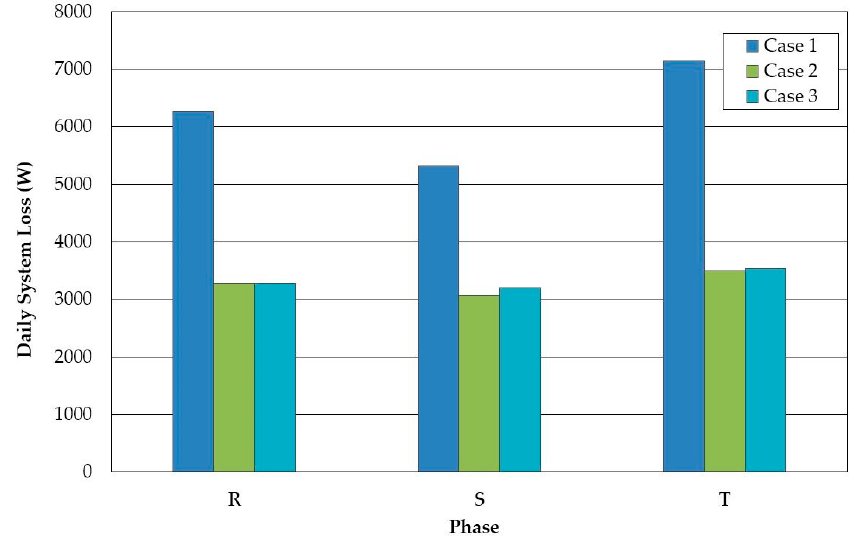
Figure 25. Comparison of the system total power loss for each